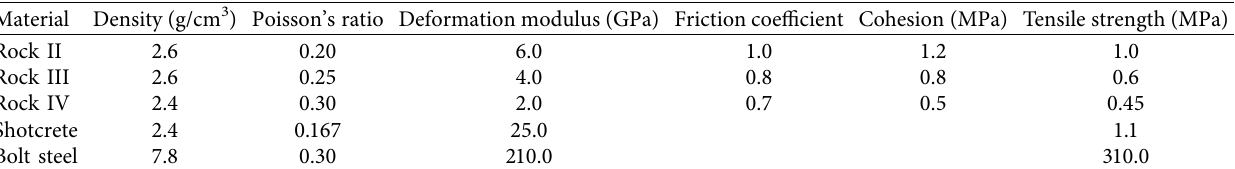
Table 3: Physical and mechanical parameters of the rock mass, shotcrete, and bolt.